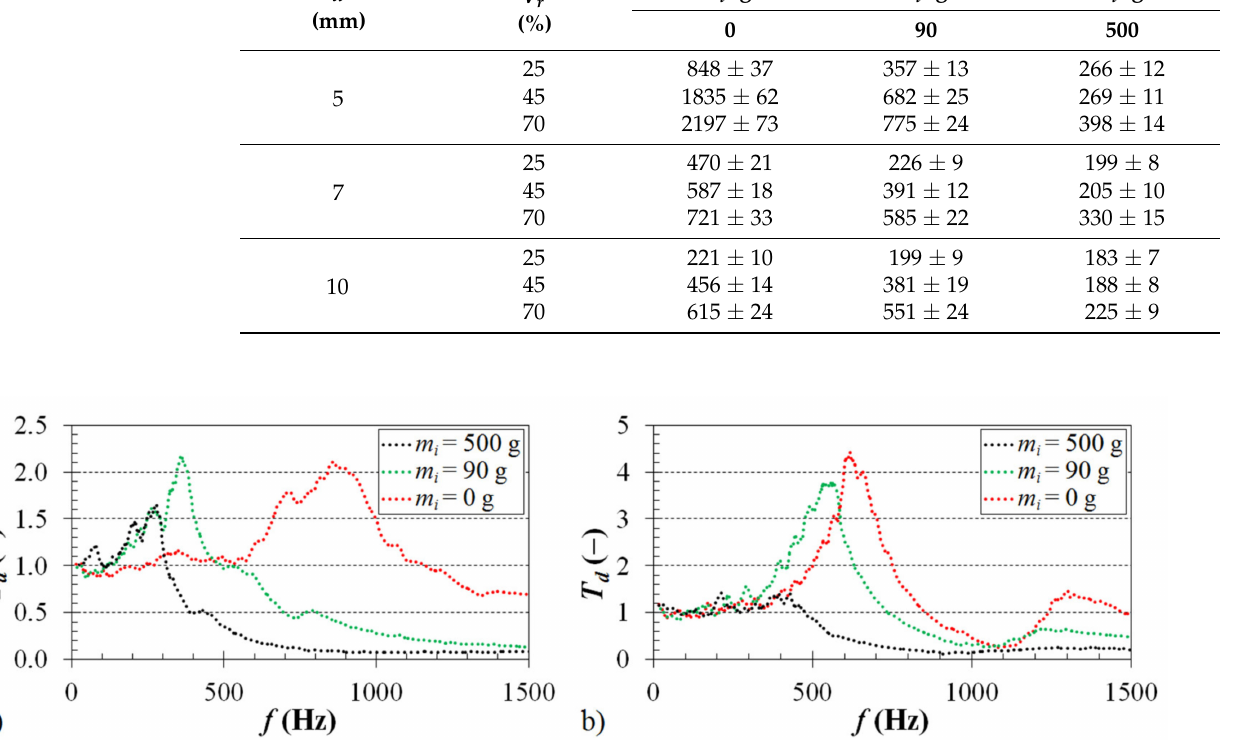
Figure 7. Influence of the inertial mass on the displacement transmissibility: ( a ) cell size a = 5 mm, volume ratio V r = 25%; ( b ) cell size a = 10 mm, volume ratio V r =